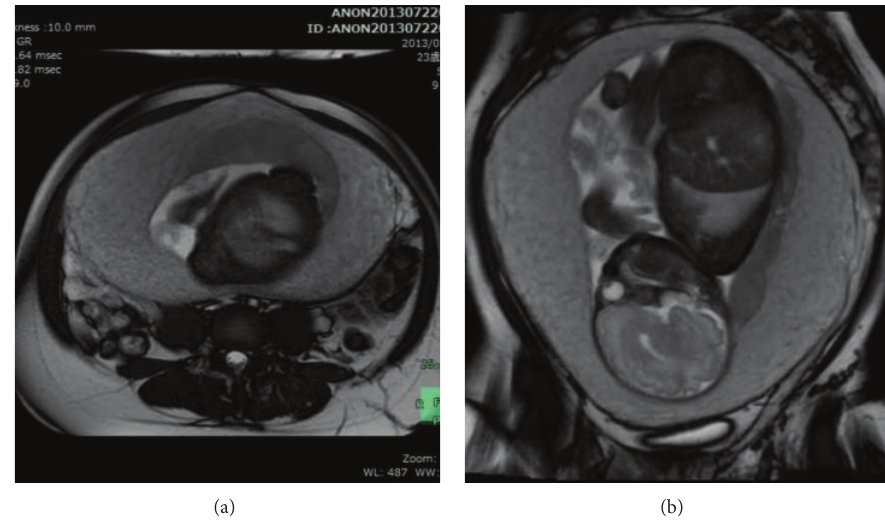
Figure 3: T2-weighted MRI showed a greatly enlarged uterus and diffuse myometrial thickening with a visible junctional zone between the endometrium and large high-intensity myometrium at 30 weeks of gestation ((a) transverse plane and (b) coronal